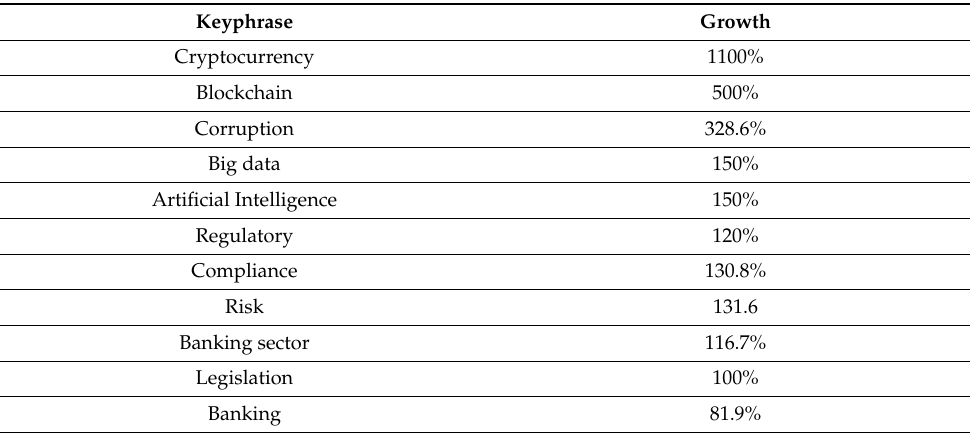
Table 13. Top ten growth keyphrases, 2017 to 2021.